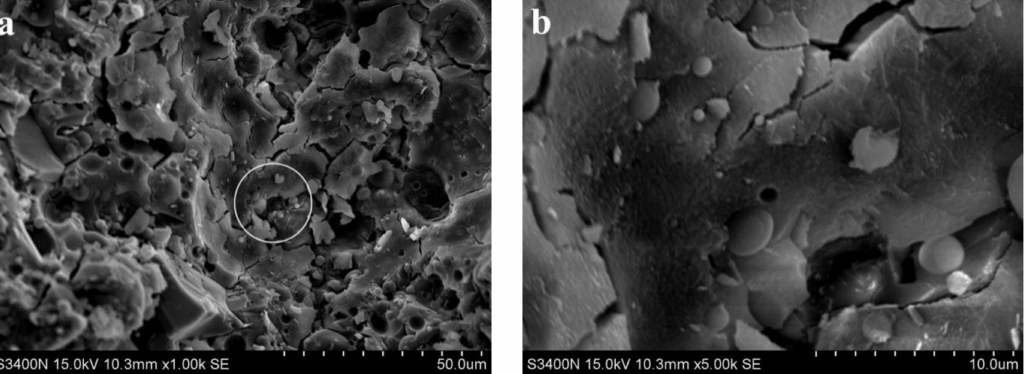
Figure 7. SEM images of 80% fly ash alkali slag cement slurry at the hydration age of 3 d. ( a ) × 1.00 k, ( b ) × 5.00 k.